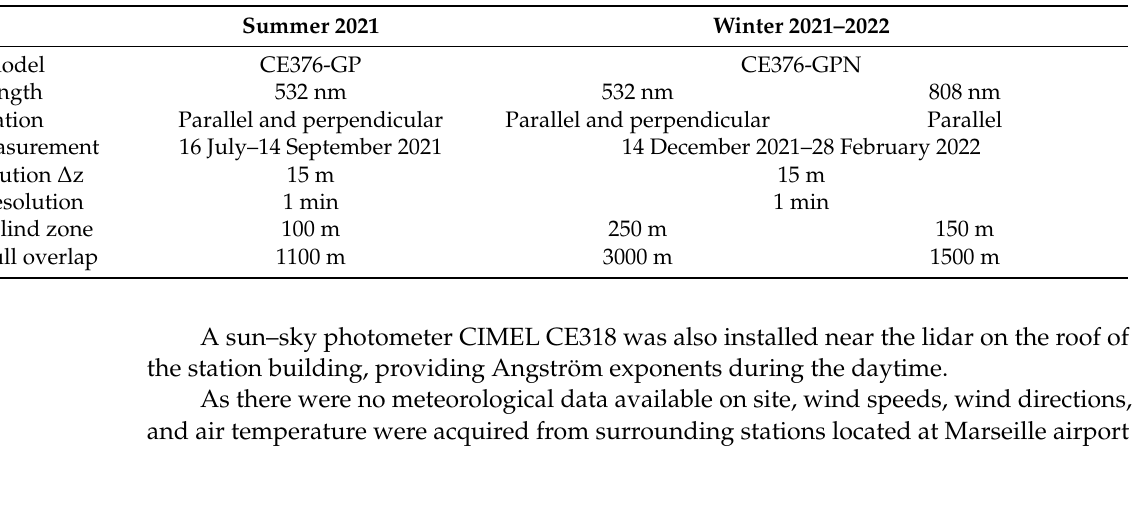
Figure 1. Map of the SUD–PACA region (left, ( a )) and zoomed in on Marseille (right, ( b )) showing the location of the measurement stations (blue: Marignane (AER), orange: Corniche (COR), red: Longchamp (LCP), green: La Valentine (LAV)). Arrows in yellow, black, and purple indicate the main wind regimes over the study periods, respectively, sea/land breezes (28%), mistral winds (21%), and eastern winds (17%). Table 1. Technical characteristics of the CE376 lidars depending on the measurement periods in